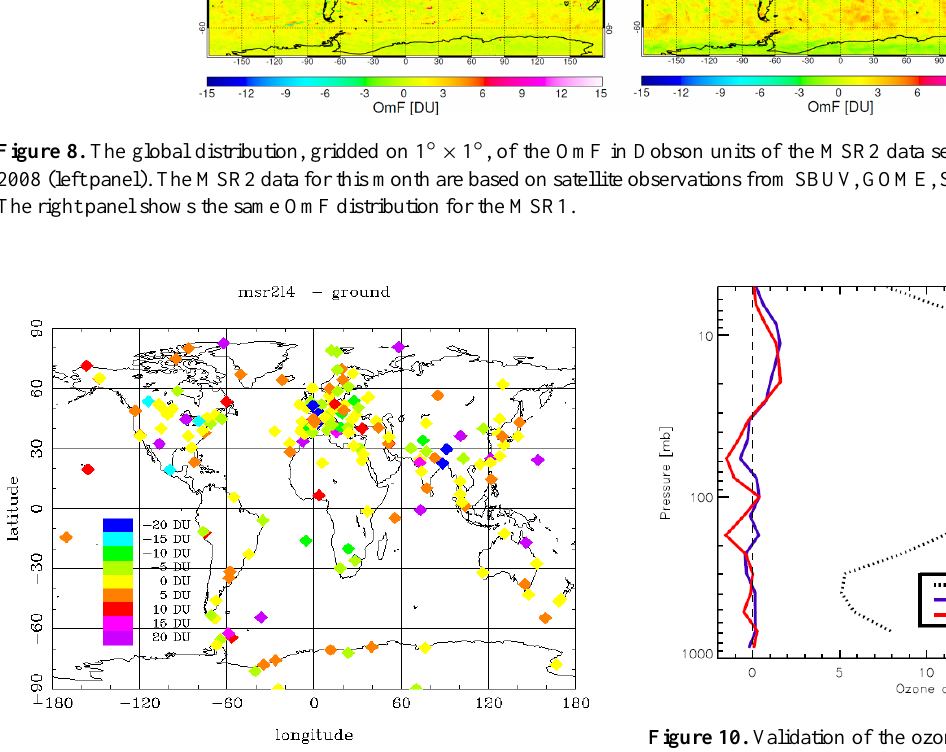
Figure 9. Mean offset (MSR2 minus ground-based) between the MSR2 level 4 data and all selected Dobson and Brewer ground- based measurements in the period 1970–2012.